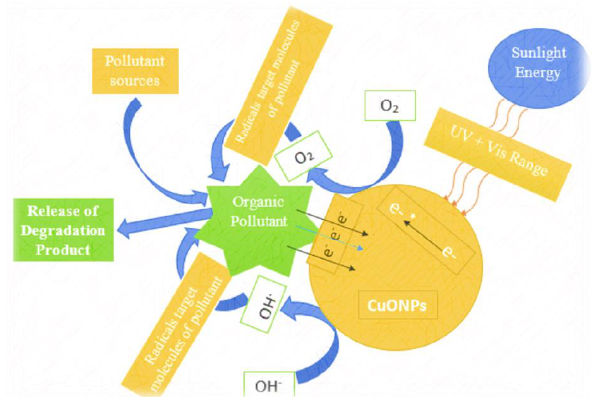
Figure 2. Scheme of pollutants degradation using the CuONPs.